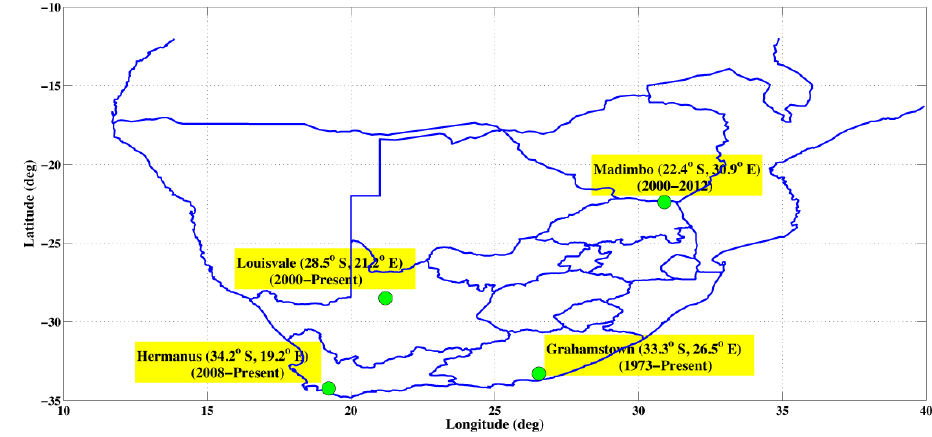
Figure 1. A map showing the South African ionosonde